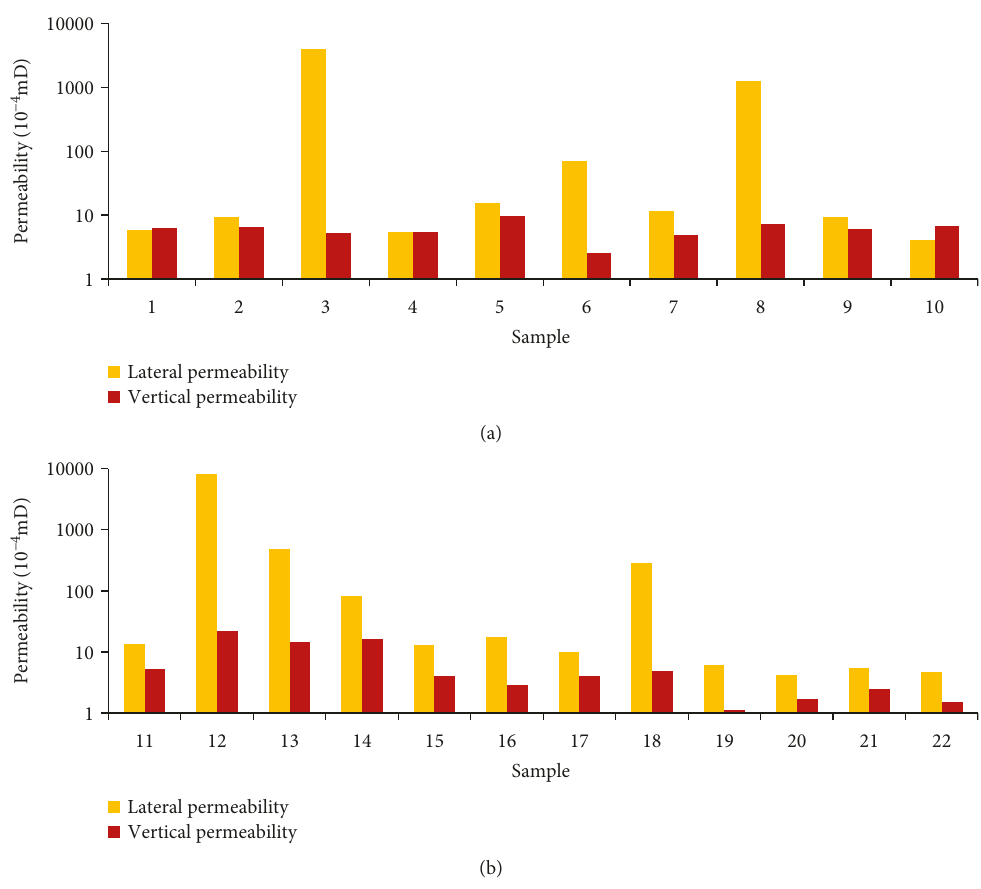
Figure 7: Histograms of the lateral and vertical permeability. (a) Samples of the Lower Cambrian Wangyinpu Formation shale, from the Jiangye-1 Well and Jiangye-2 Well. (b) Samples of the Lower Silurian Longmaxi Formation shale, from the Pengye-1 Well. See Figure 1 for the well locations.